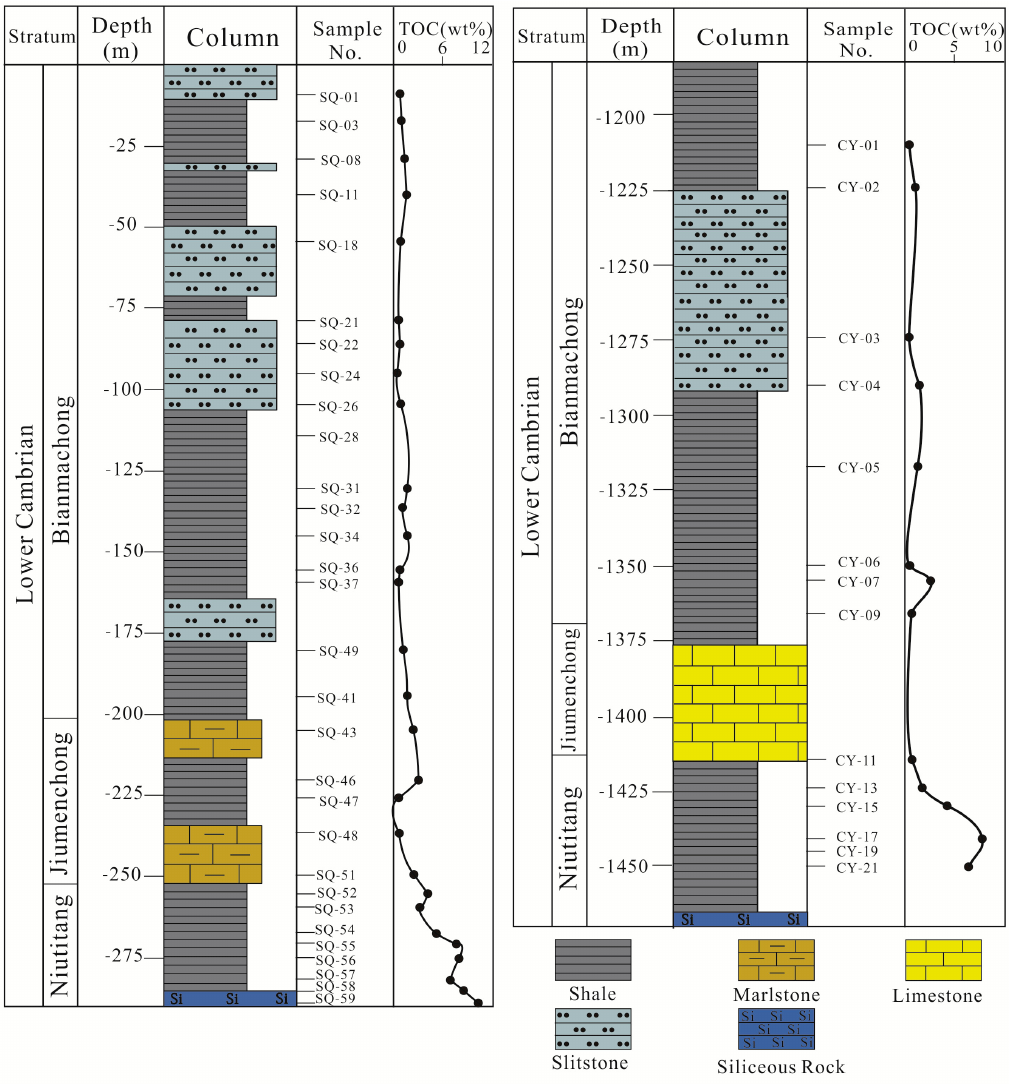
Figure 2. Stratigraphic column of the SQ-1 and CY-1. The left is SQ-1 and the right is CY-1.